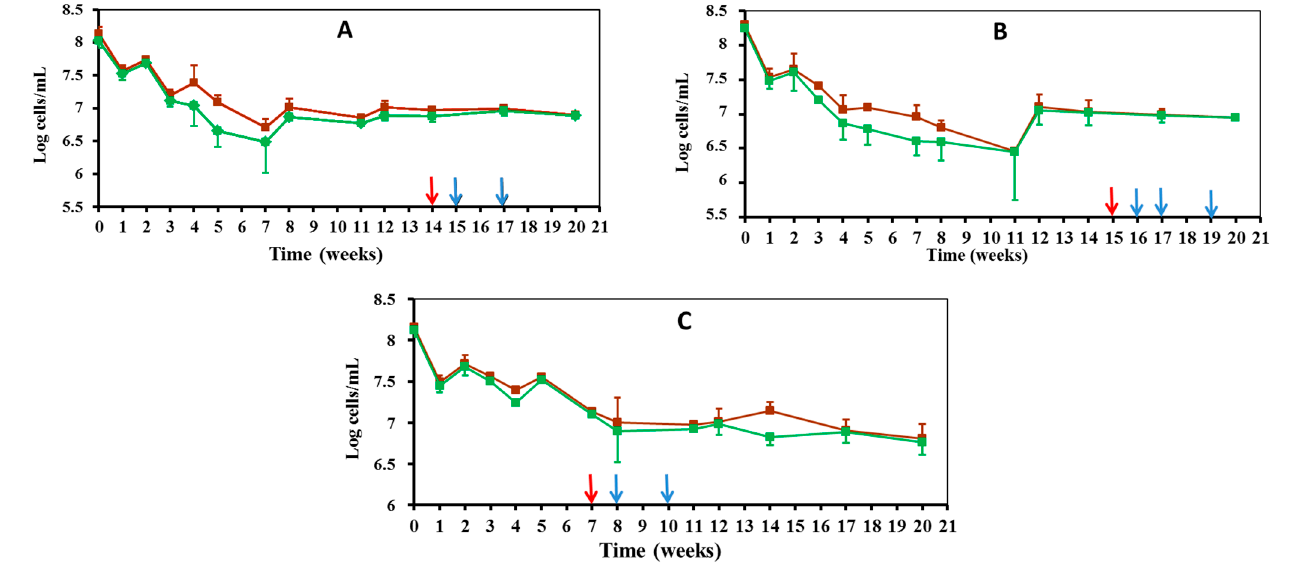
Figure 2. Direct counts of total (brown line) and viable (green line) Edwardsiella cells maintained under starvation conditions in FSLW microcosms at 7 °C: ( A ) E. piscicida V12.1; ( B ) E. piscicida V57.2; ( C ) E. tarda V43.2. Red arrow indicates the beginning of the VBNC period. Blue arrows indicate the timing of resuscitation experiments of VBNC Edwardsiella cells.